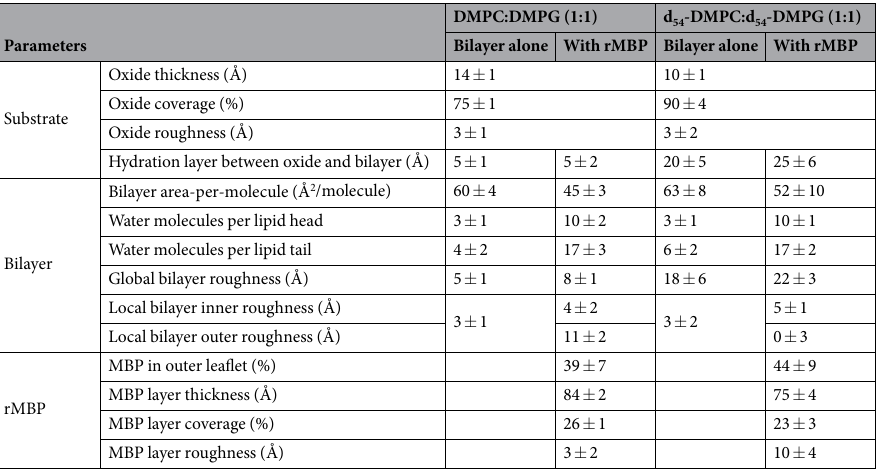
Table 2. Neutron reflectometry